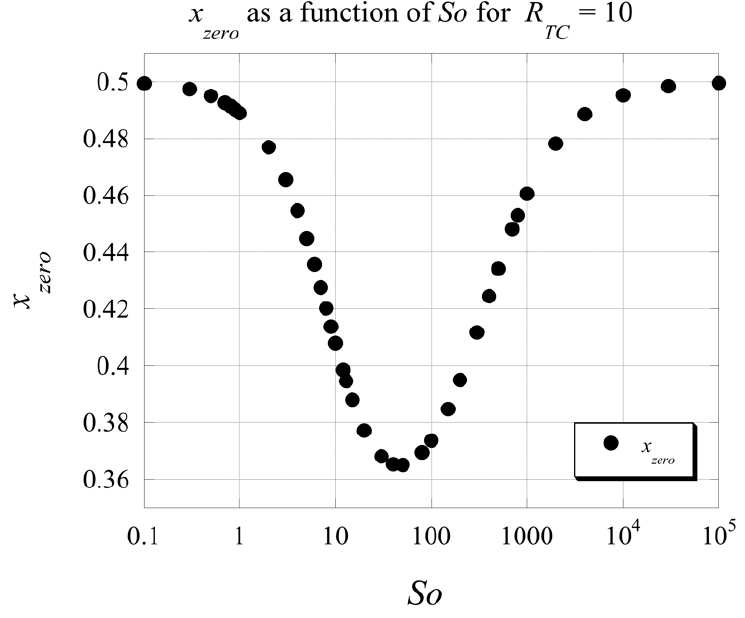
w with the Soret